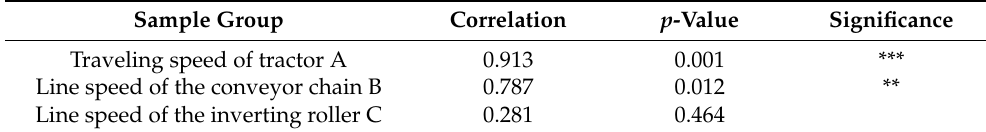
Table 9. Correlation of paired samples.